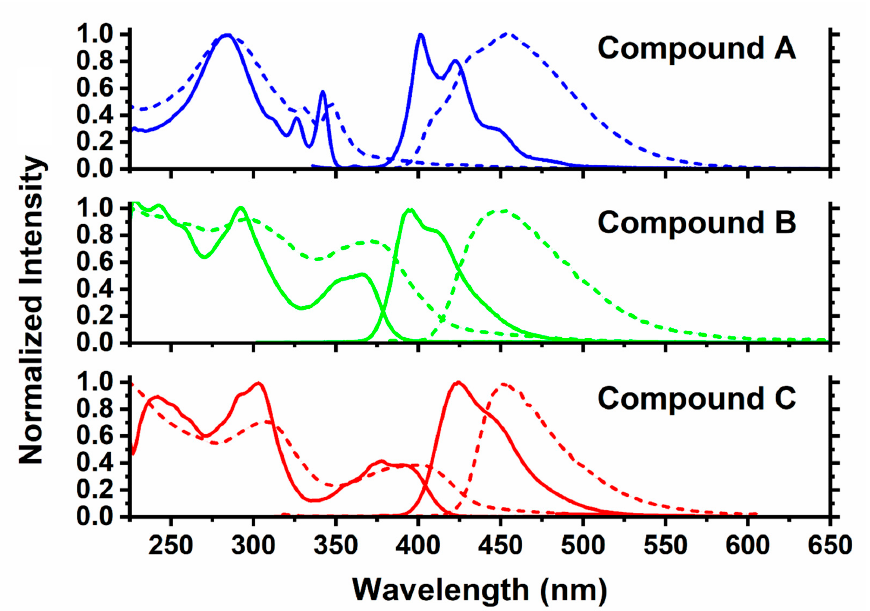
Figure 5. Normalized UV-vis absorption and fluorescence spectra of compound A , B , and C in DCM solutions (1 μ M, solid lines) and neat films (dashed lines).